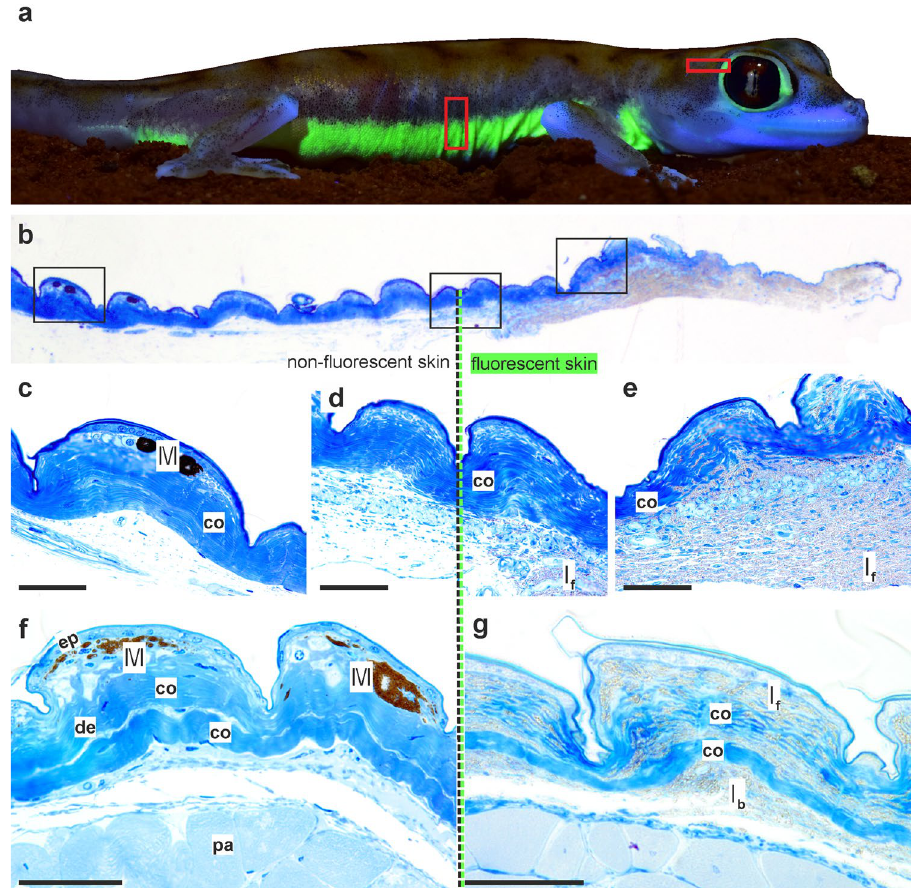
Figure 3. Histology of Pachydactylus rangei skin. ( a ) Boxes indicating schematic position of histological samples; ( b ) section from temporal region of eye with transition from non-fluorescent skin (left; posterior in a) to fluorescent skin (right, anterior in a); schematic boxes are enlarged below; ( c ) non-fluorescent skin containing melanophores; ( d ) transition between non-fluorescent to fluorescent skin; ( e ) fluorescent skin containing a large amount of iridophores with granular material; ( f , g ) sections from the ventrolateral stripe, non-fluorescent ( f ) and fluorescent ( g ). Scale bars = 50 µm. co collagen fibre, de dermis, ep epidermis, I f fluorescent iridophores, I b basal (non-fluorescent) iridophores, M melanophore, pa parenchymatous